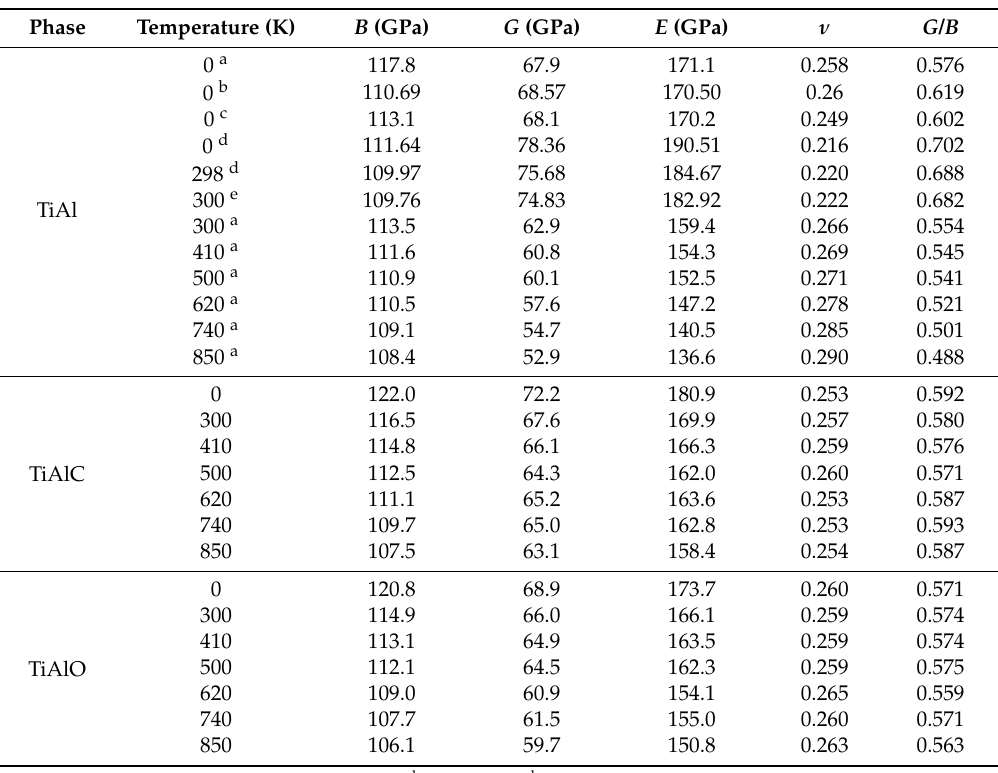
Table 2. The calculated elastic modulus, including the bulk modulus ( B ), shear modulus ( G ), Young’ s modulus ( E ), Poisson’ s ratio ( ν ), and G / B of TiAlC and TiAlO at different temperatures